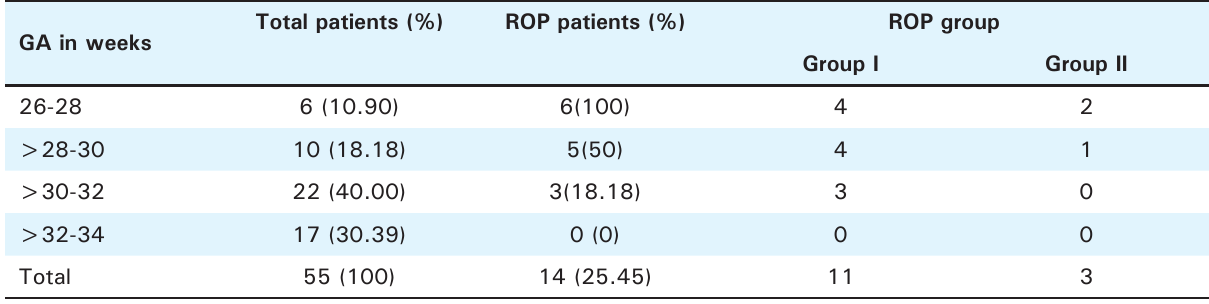
Table 4. Incidence and severity of ROP in relation to gestational age Total patients (%) ROP patients (%) GA in weeks